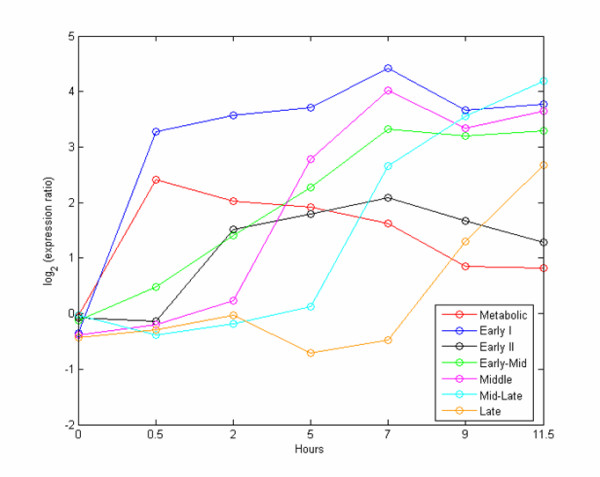
Expression patterns of the 39 representative genes in the yeast sporulation data. These 39 representative genes represent seven expression patterns in the yeast sporulation data. The figure shows the average expression profile for each pattern.